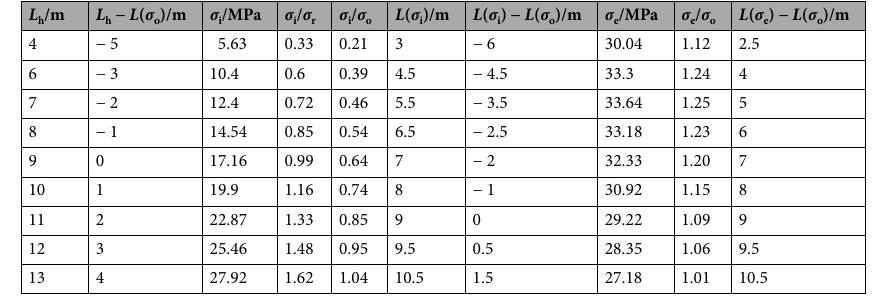
Table 5. Summary of dynamic change indexes of chamber surrounding rock under different L h.